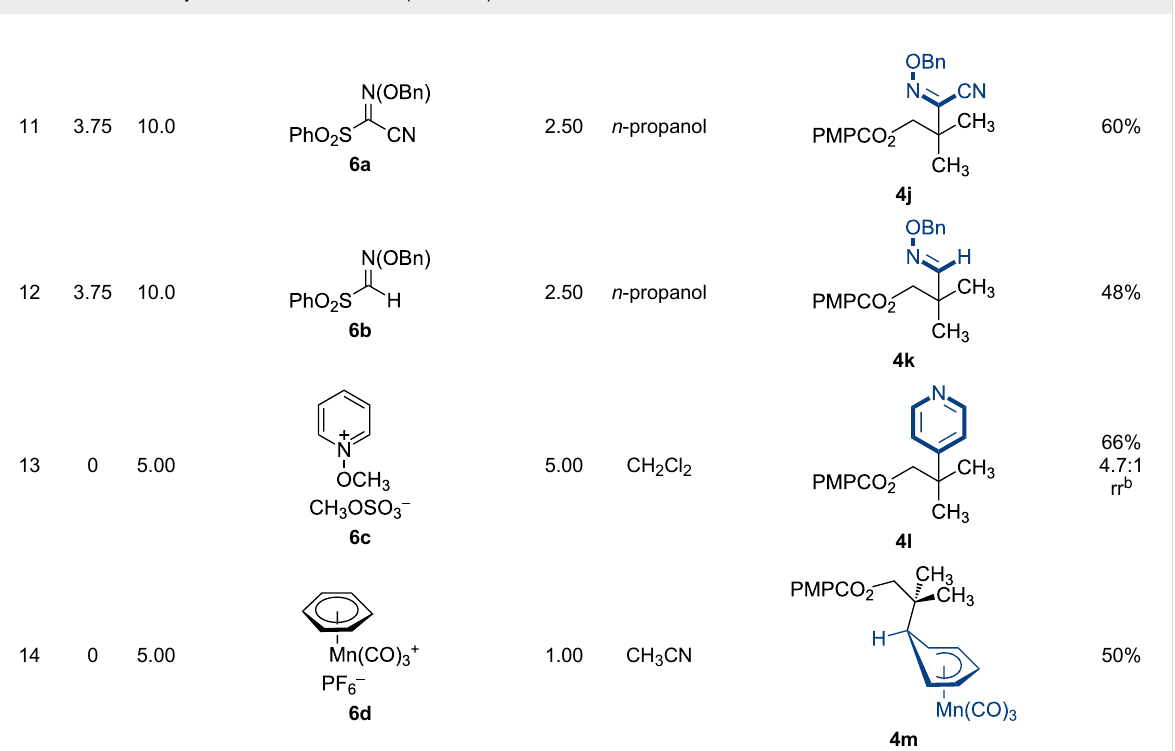
Table 1: Markovnikov Hydrofunctionalization of 3a . a